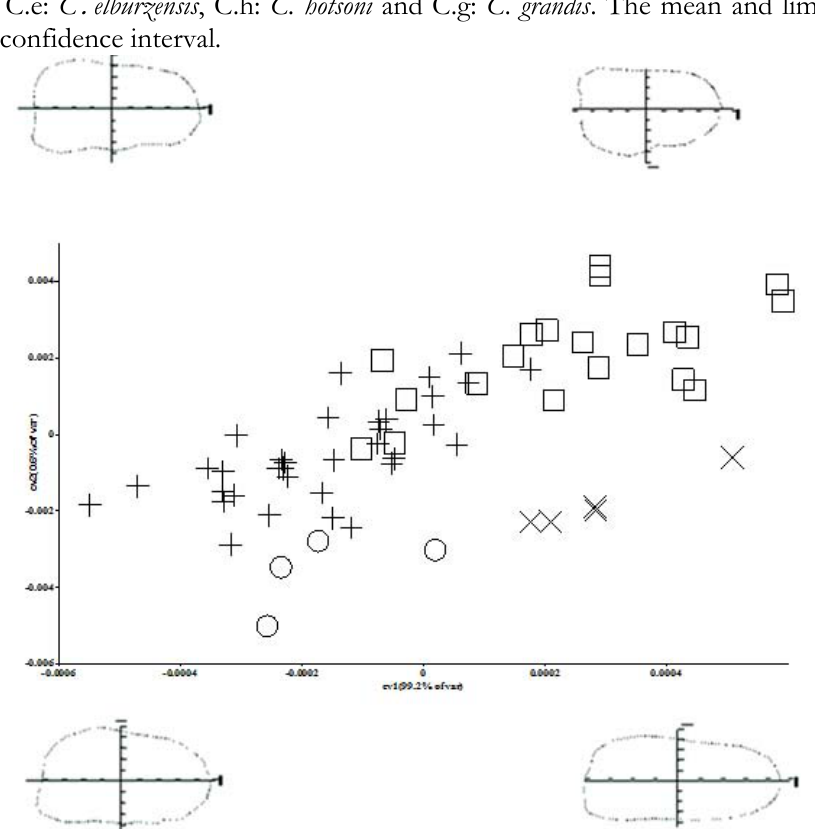
F IGURE 4. Ordination of eleven populations of Calomyscus in the space of canonical axes 1 and 2. Open circles: C. hotsoni , open square: C. bailwardi , multiply sign: C . grandis , plus sign: C . elburzensis